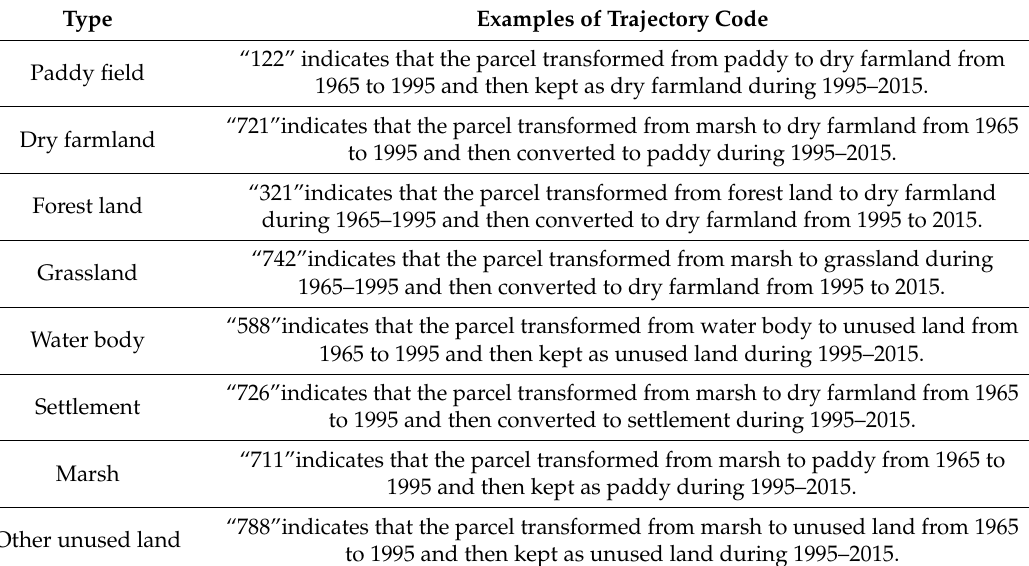
Table 2. Land-use change